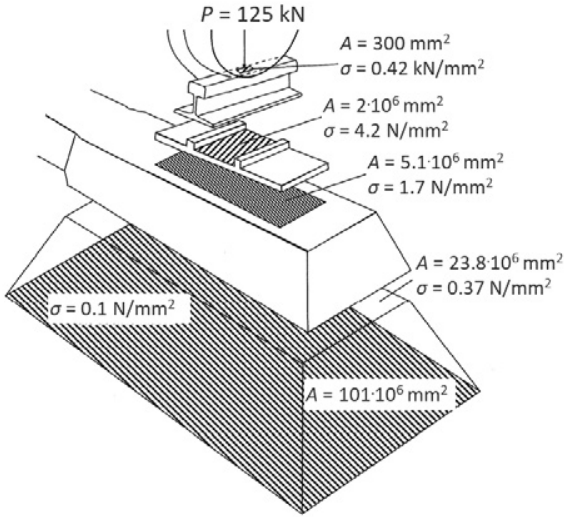
Figure 1. Schematic explanation of the stress distribution from the wheel to the surface of the subgrade (modified after Führer